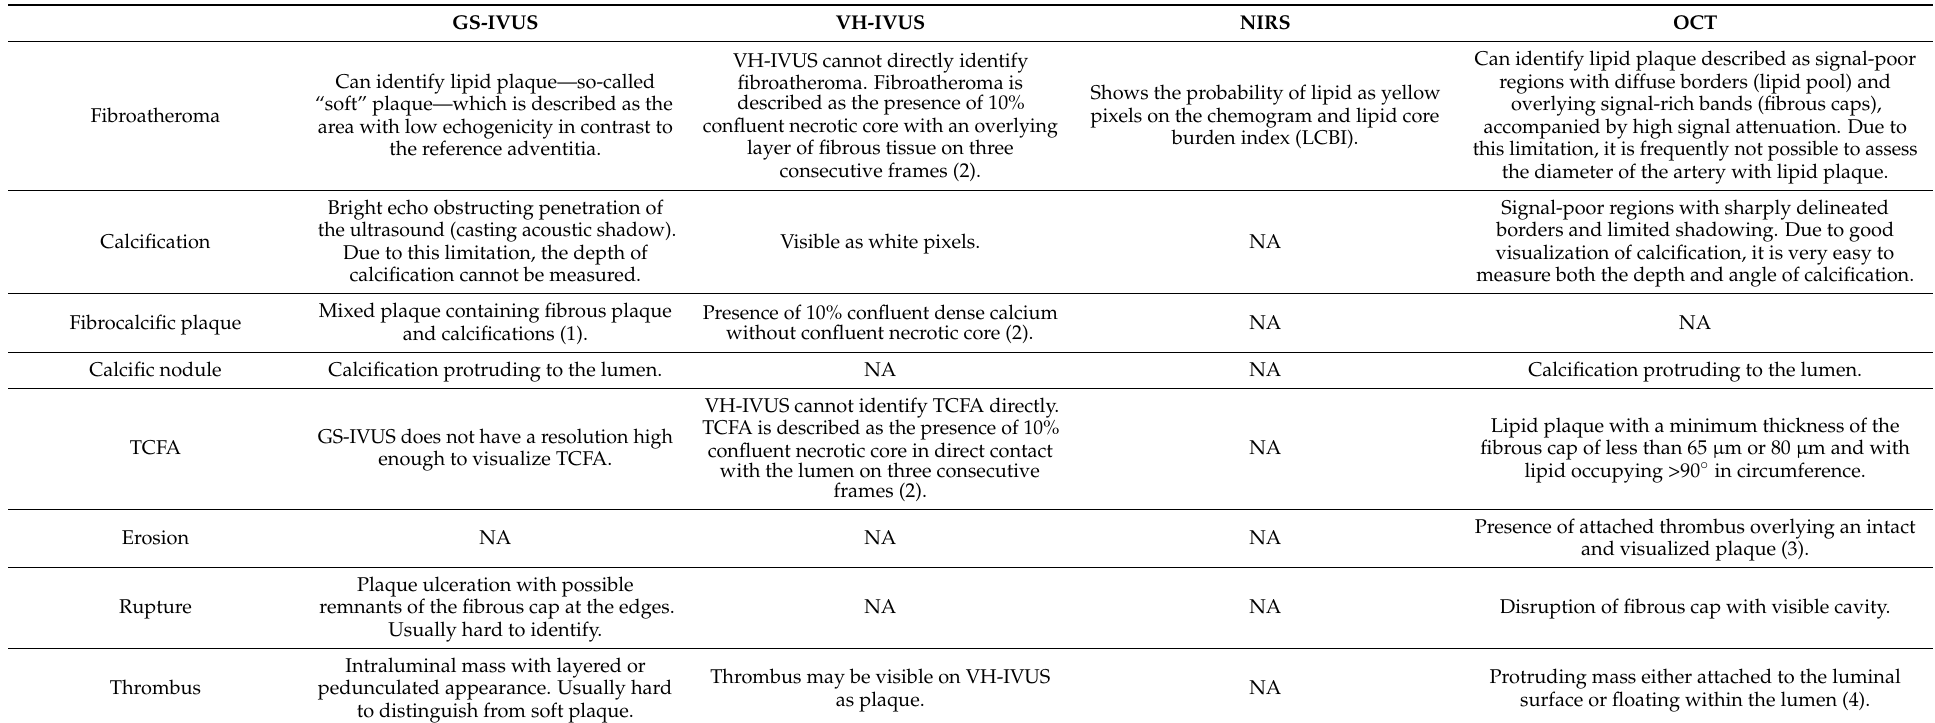
Table 4. Advantages and disadvantages of respective intravascular